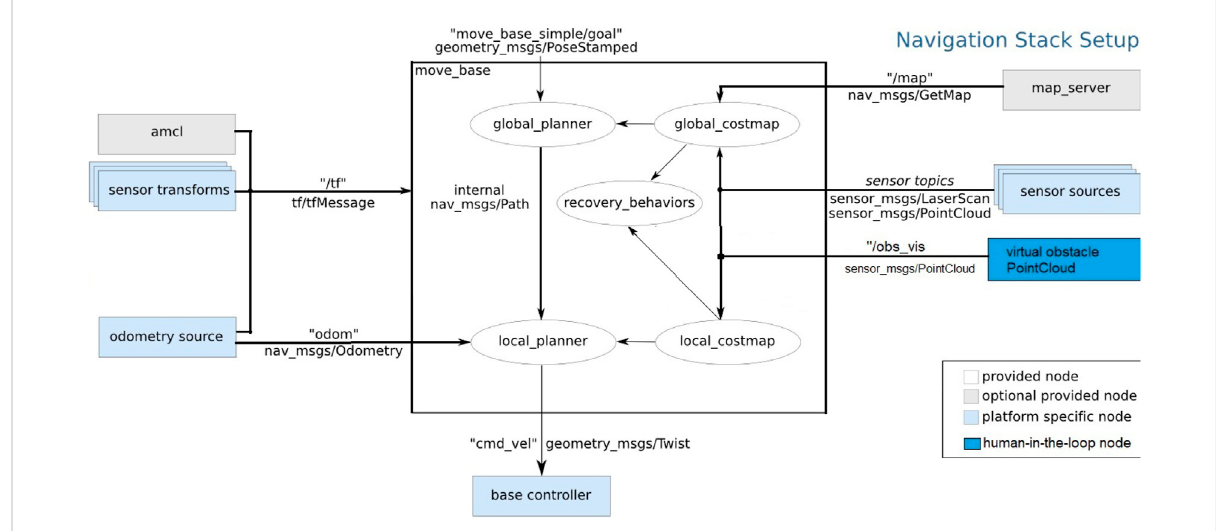
FIGURE 4 ROS mobile-based navigation stack node with the trigger source [modi fi ed from ROS.org (2018)]: the virtual obstacle PointCloud node publishes a topic which has a sensor message for the robot cost